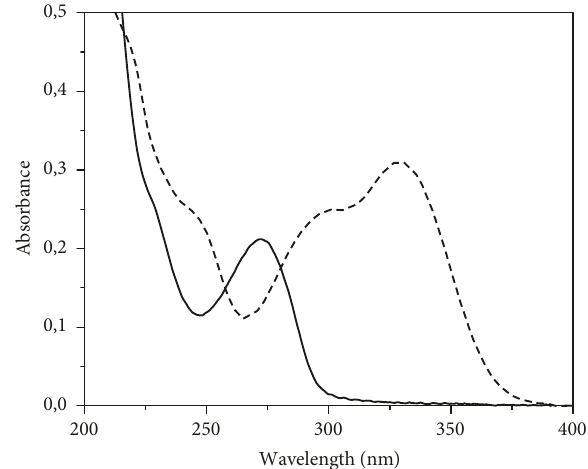
Figure 1: UV/Vis absorption spectra of caffeine (continuous line) and CGA (dashed line) chemical standard, respectively, at 5.3 ⋅ 10 −3 mg/ml and 8.5 ⋅ 10 −3 mg/ml. Measurements were performed at 25 ∘